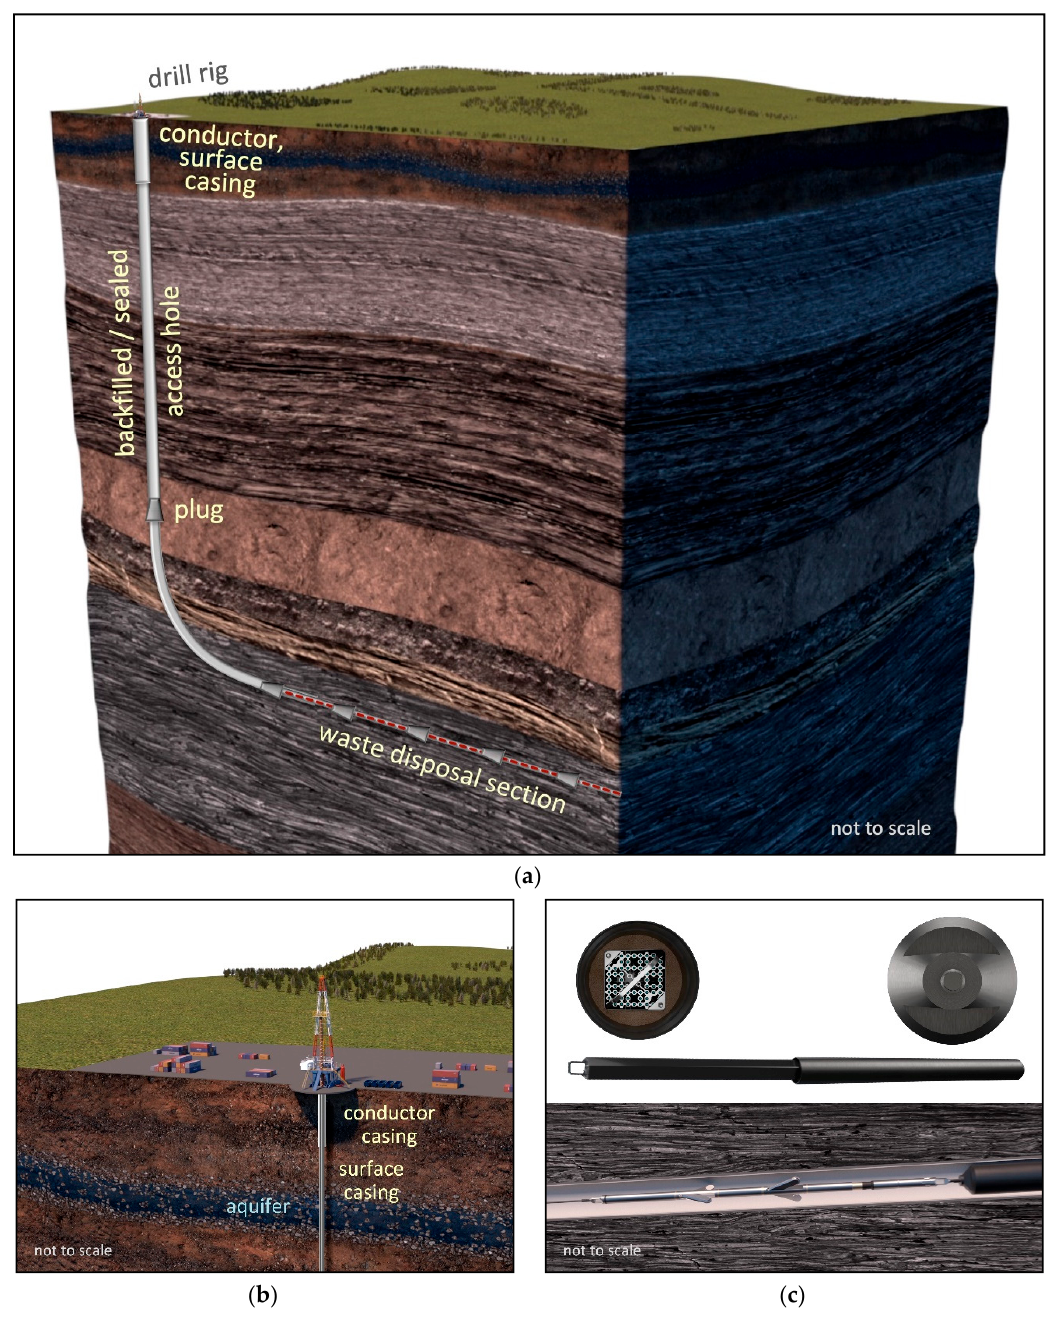
Figure 1. Schematic of a deep horizontal drillhole repository (not to scale); ( a ) a vertical access hole is drilled to the kickoff point below confining layers, where the hole is gradually curved until it is approximately horizontal. It then continues for a few hundred meters to several kilometers; this near-horizontal part of the drillhole is the waste disposal section of the repository, where canisters holding individual spent nuclear fuel assemblies are emplaced end-to-end, before the drillhole is plugged and sealed; ( b ) multiple casings provide stability, protect aquifers and guide waste canister emplacement; ( c ) spent nuclear fuel assemblies are placed into canisters which are capped; a tractor, coiled tubing or drill pipe is used to push the canister into the horizontal disposal section of the drillhole.